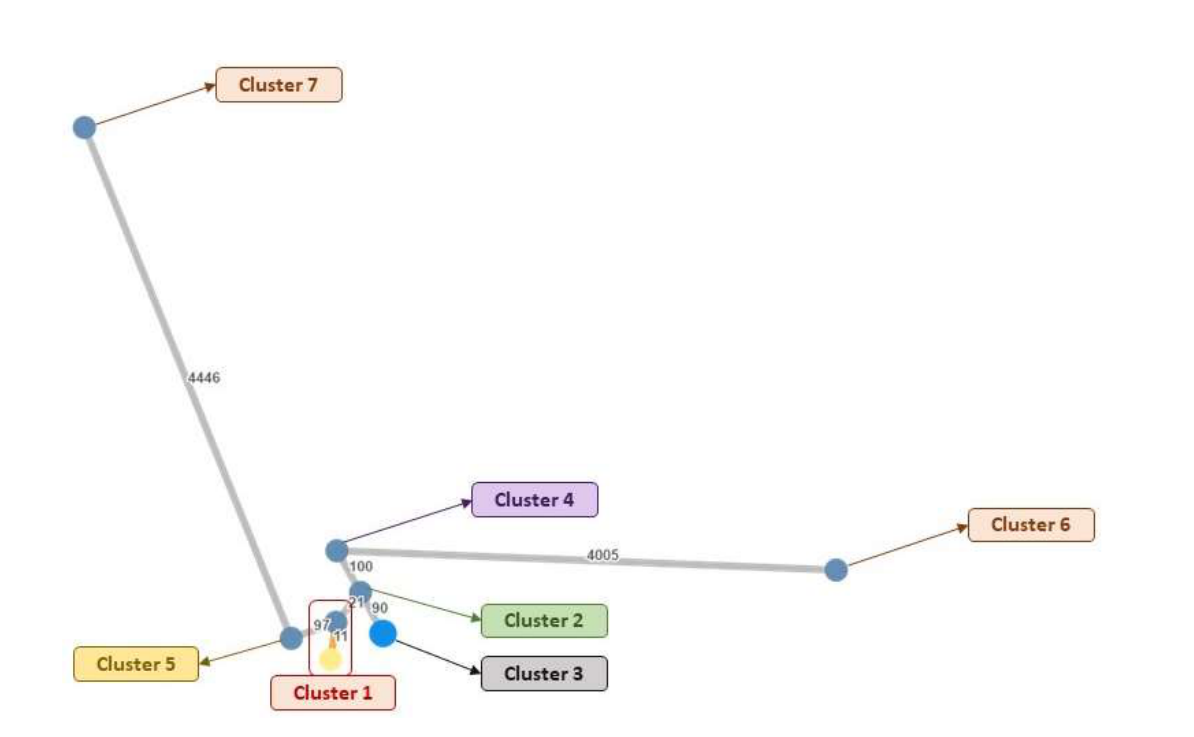
Figure 2. A minimum spanning tree based on the number of allelic differences between the isolates. The number of allelic differences are indicated on the lines connecting the isolates.